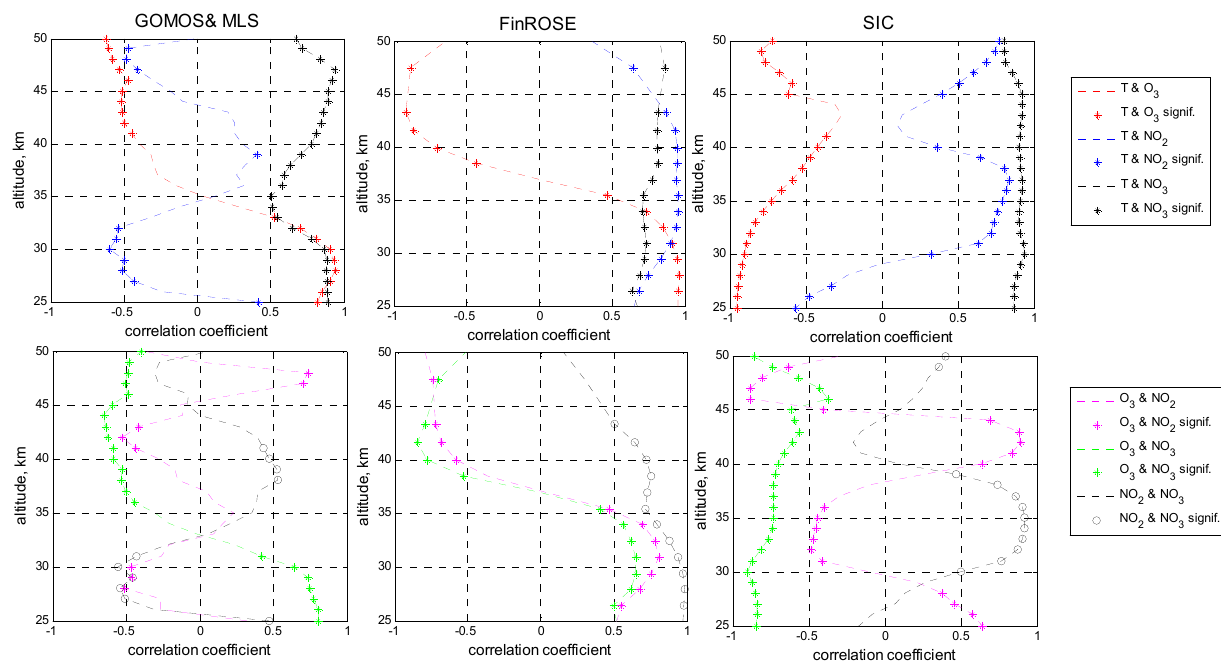
Figure 6 Correlation coefficients between temperature and trace gases using zonally averaged data from 1–25 January 2006 at latitudes 70–90 ◦ N; left GOMOS trace gases and MLS temperature, center: FinROSE simulations, right: SIC simulations. Markers (stars and circles) indicate values with statistically significant correlation (i.e., values with probability of zero correlation smaller than 5%)